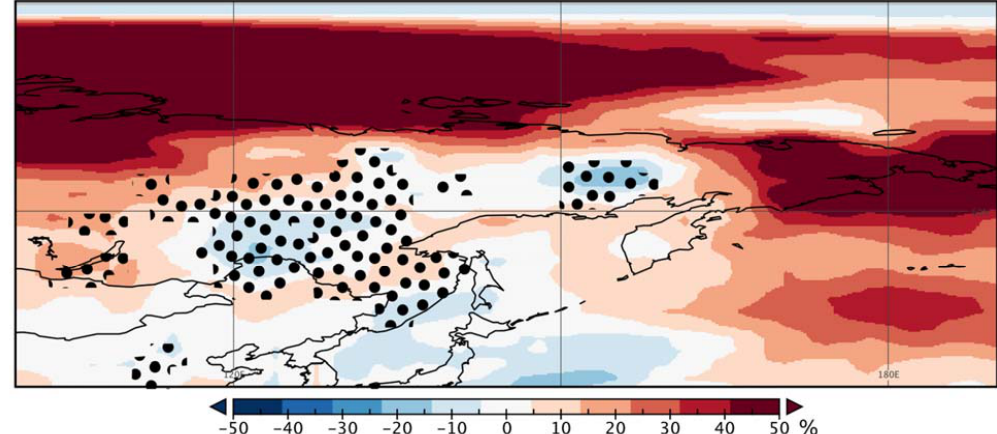
Figure A3. Relative change in summer average (June–July–August, averaged over 5 years) CCN(0.2%) concentration in response to altered BVOC emissions (see methods). Dotted areas denote regions where summer wildfire emission exceeds 10 − 11 kgm − 2 s − 1 (see Fig.